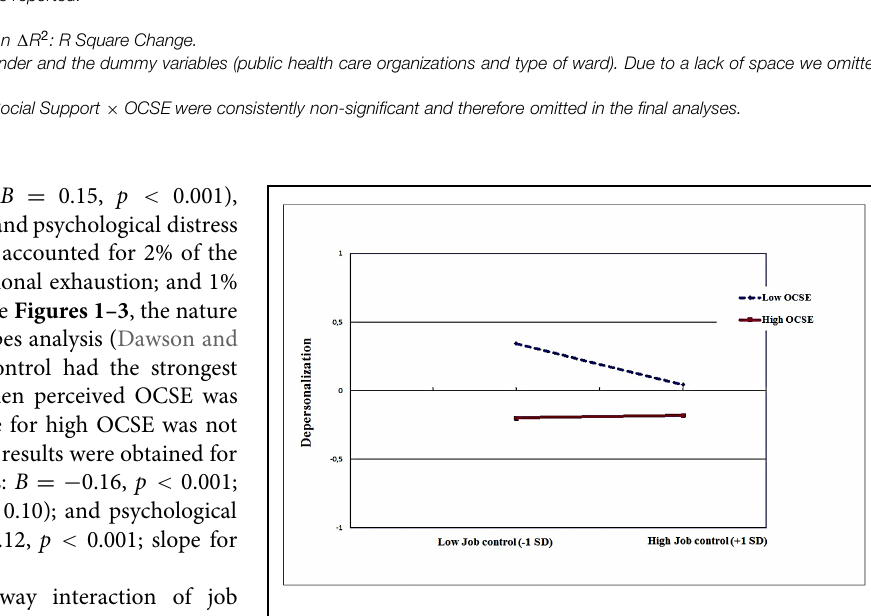
FIGURE 2 | Job control X OCSE, predicting depersonalization.